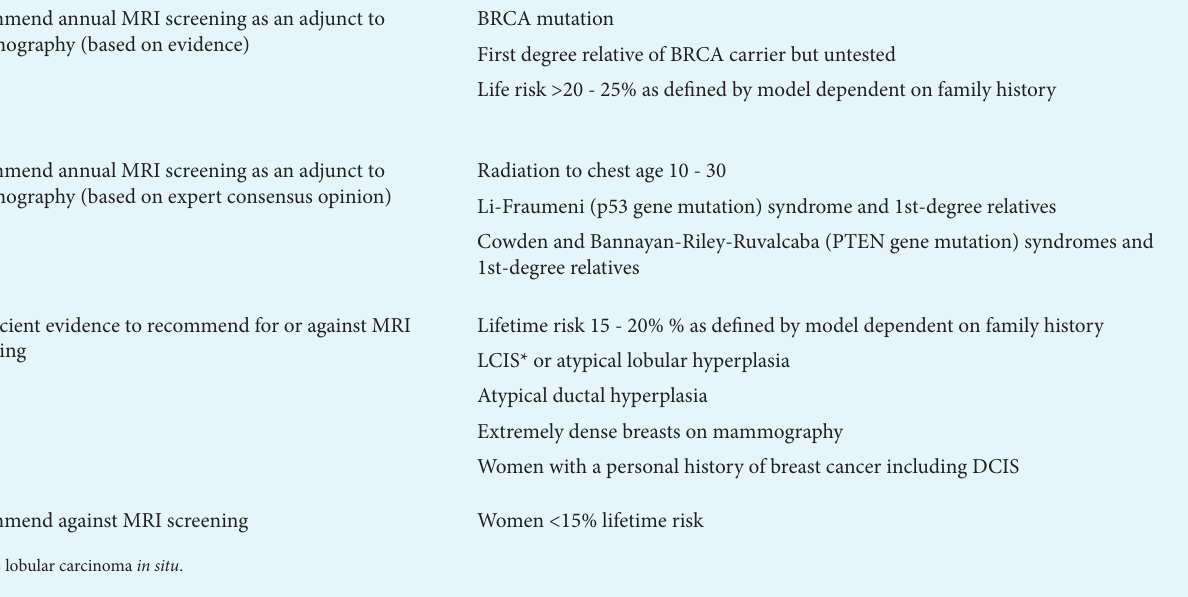
Recommend annual MRI screening as an adjunct to mammography (based on